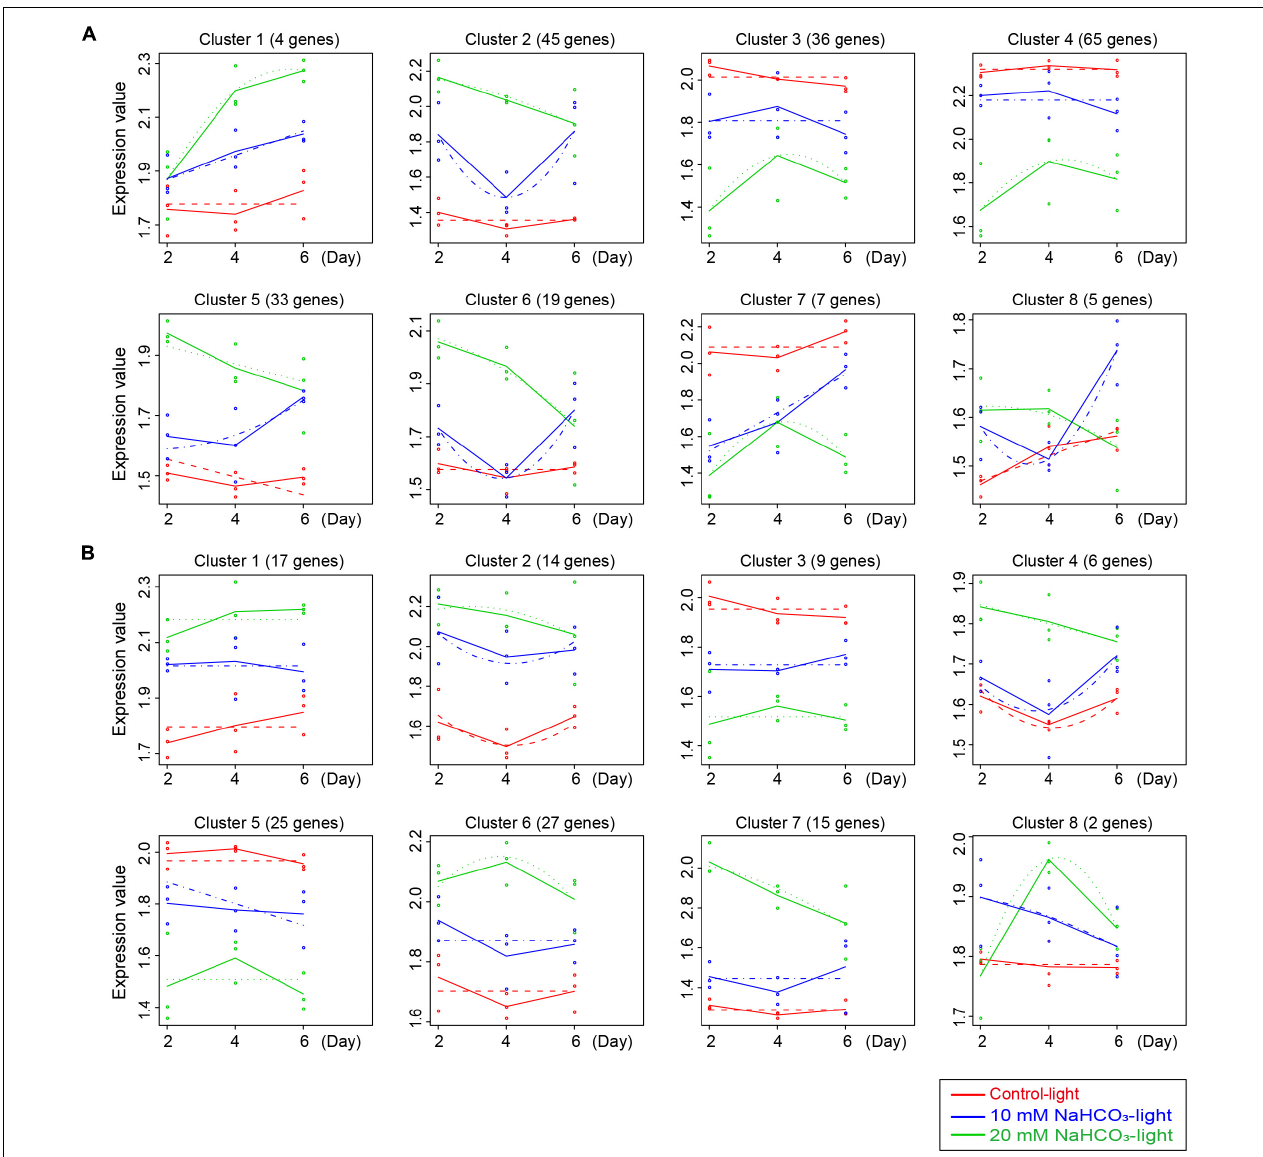
FIGURE 5 | Data visualization according to the cluster analysis. Each map shows the average expression profiles of the gene clusters from all samples. The horizontal coordinates represent different time points, and the vertical coordinates represent the treated expression values. Different colored lines represent different groups (red, blue, and green lines represent the control light, 10 mM NaHCO 3 -light, and 20 mM NaHCO 3 -light groups, respectively) and show the actual average value of gene expression at each time point. Different points represent the actual average expression levels for specific individual samples. The dotted lines represent the fitted curves of gene expression at each time point. (A,B) Are the cluster analysis for 985 SAGs and 1,180 DEGs,